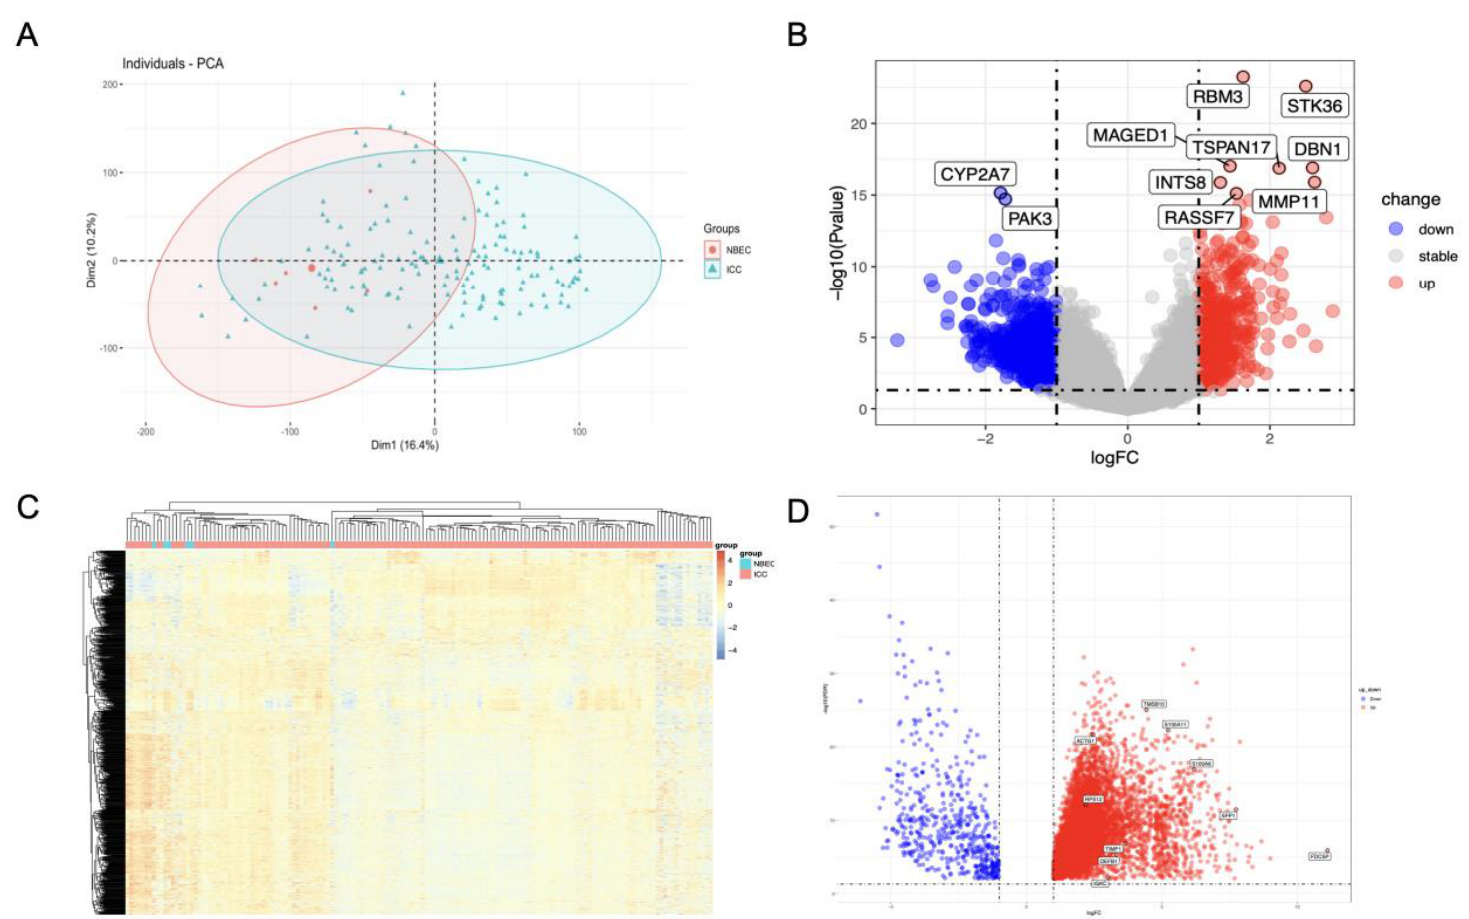
Figure 2. DEG analysis. ( A ) PCA plot of GSE32225 dataset. Green dot represents the ICC sample, red dot represents the normal biliary epithelial cells. ( B ) Volcano plot of GSE-DEGs constructed using log2FC values and adjusted p -value. Red and blue points in the plot represent the up-regulated and down-regulated genes defined as described. ( C ) Hierarchical cluster heatmap of GSE-DEGs. ( D ) Volcano plot of TCGA-DEGs.